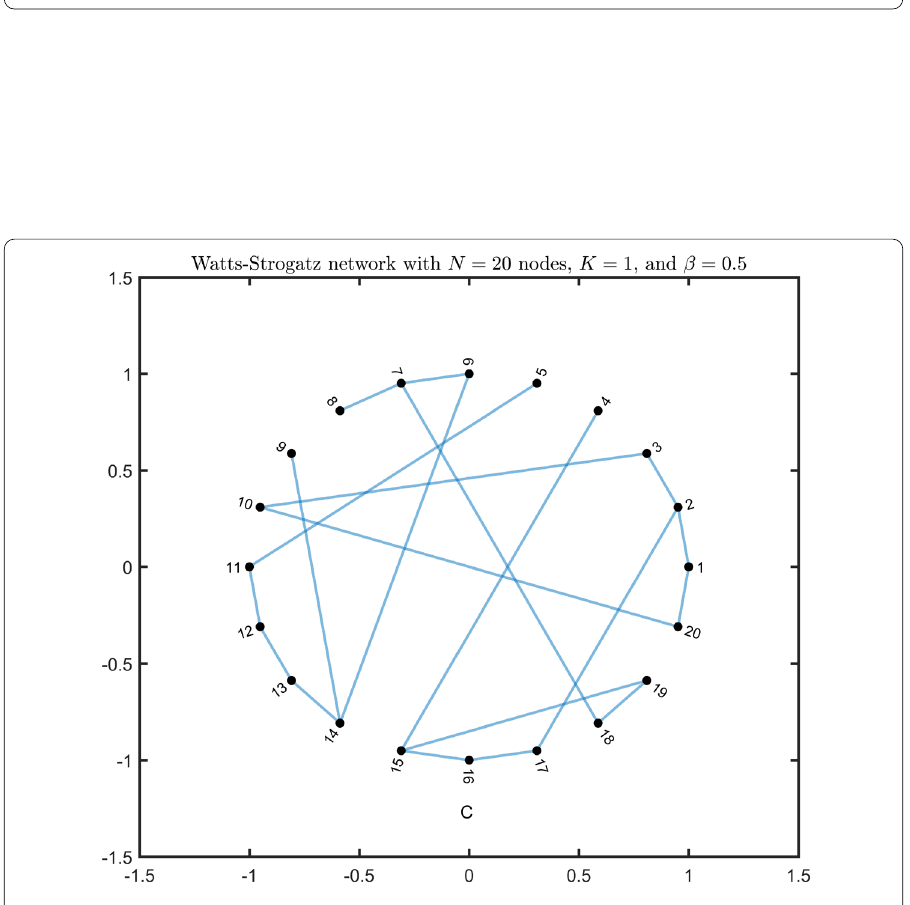
Figure 15 The topology structure of Watts-Strogatz complex network with N = 20, K = 1 and β =